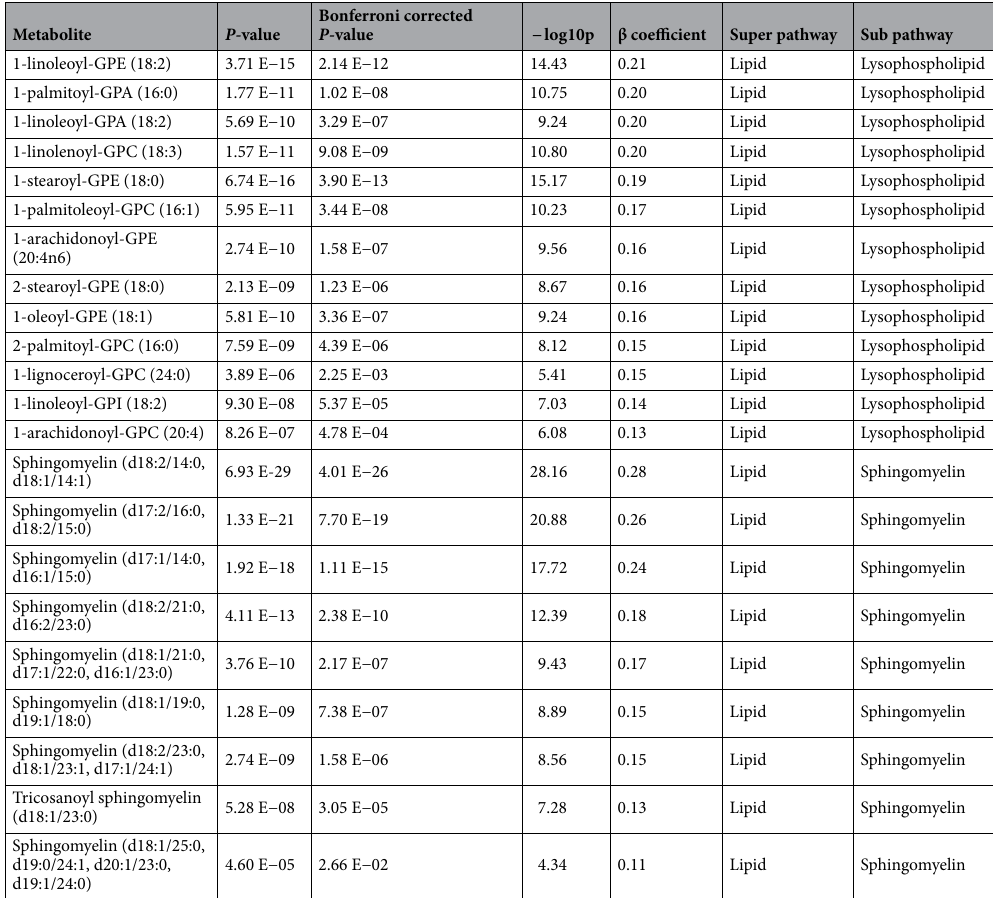
Table 2. Metabolites significantly increased in women relative to men over time. Significant results presented following mixed-effects modeling of each of the 578 individual metabolites measured at day 0, 3 and 7. All estimates adjusted for age, SAPS II, admission diagnosis, 25(OH)D at day 0, absolute change in 25(OH)D level at day 3 and plasma day (as the random-intercept). A multiple test-corrected threshold of P -value < 8.65 × 10 –5 was used to identify all significant associations. GPC is glycerophosphorylcholine; GPE